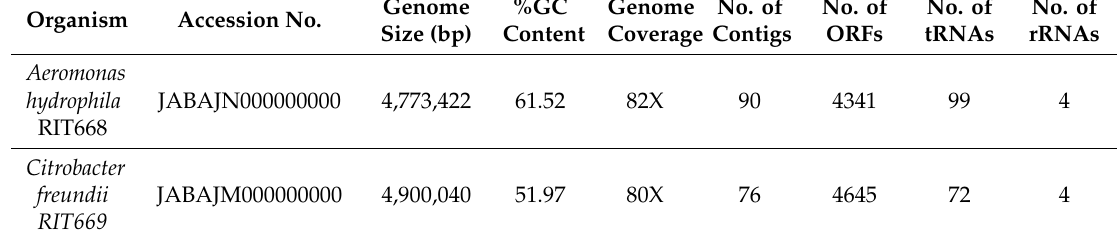
Table 1. Summary of whole-genome sequencing of A. hydrophila and C. freundii .